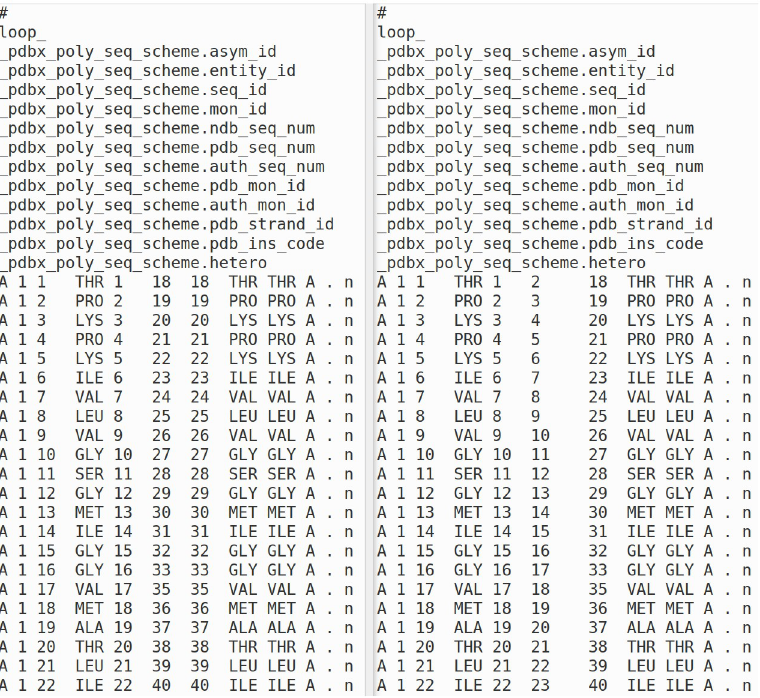
Fig 3. Renumbering of the pdbx_poly_seq_scheme table from 2aa3 processed by PDBrenum. Left: the original file from the PDB. Right: the renumbered file from PDBrenum. The original author numbering is given in column 6 of the table on the left (18, 19, 20, etc.), which is replaced with the UniProt numbering (entry Q9PRK9) for this chain (2,3,4, etc) in column 6 of the table on the right. The original author numbering has been placed in column 7 of the table on the right (i.e., in the auth_seq_num